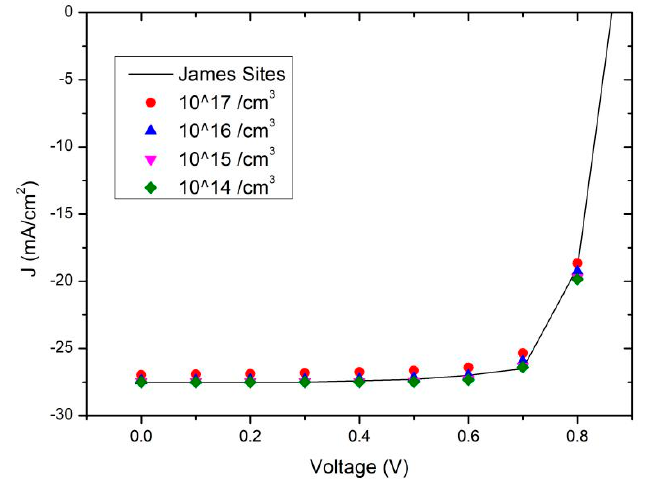
Figure 9. The comparison of experimental data from the other group [21] and our theoretical model.